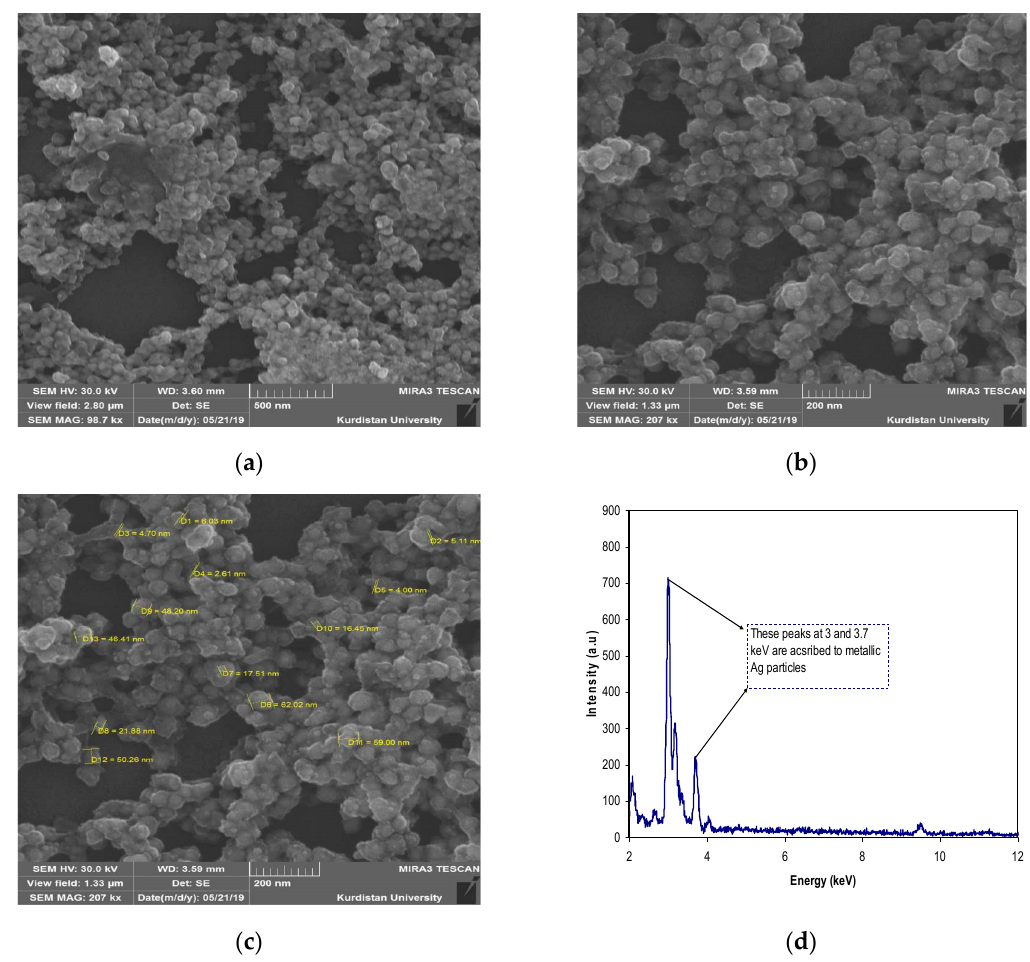
Figure 7. Emission scanning electron microscopy images (FESEM) for ( a ) magnification (MAG): 98.7 kx, ( b ) MAG: 207 kx, ( c ) size of Ag NPs at MAG: 242 kx, and ( d ) energy dispersive analysis of X-rays (EDAX).